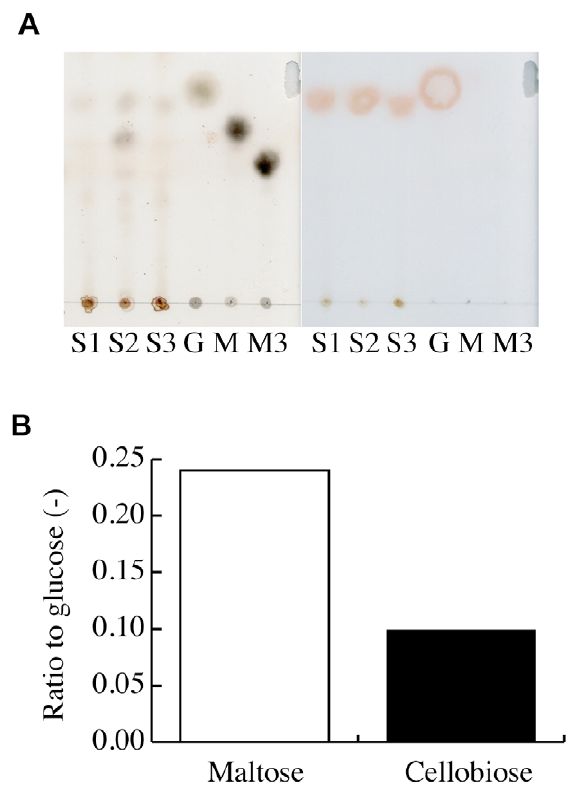
Figure 2. Identification of oligosaccharides in H . gigas whole- body extracts. Oligosaccharides were extracted with DDW from 3 crushed H . gigas and were separated by TLC and stained with H 2 SO 4 for oligosaccharides (A, left) or the Glucose CII Kit for glucose (A, right). Glucose (G), maltose (M), and maltotriose (M3) were used as standard. The maltose and cellobiose contents were measured by the increase in the glucose content after a - or b -glucosidase treatment (B). doi:10.1371/journal.pone.0042727.g002 PLOS ONE |